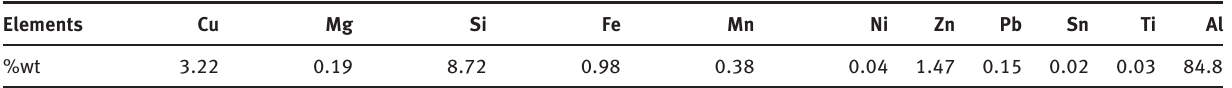
Table 1: Composition of the aluminum (A380) alloy.